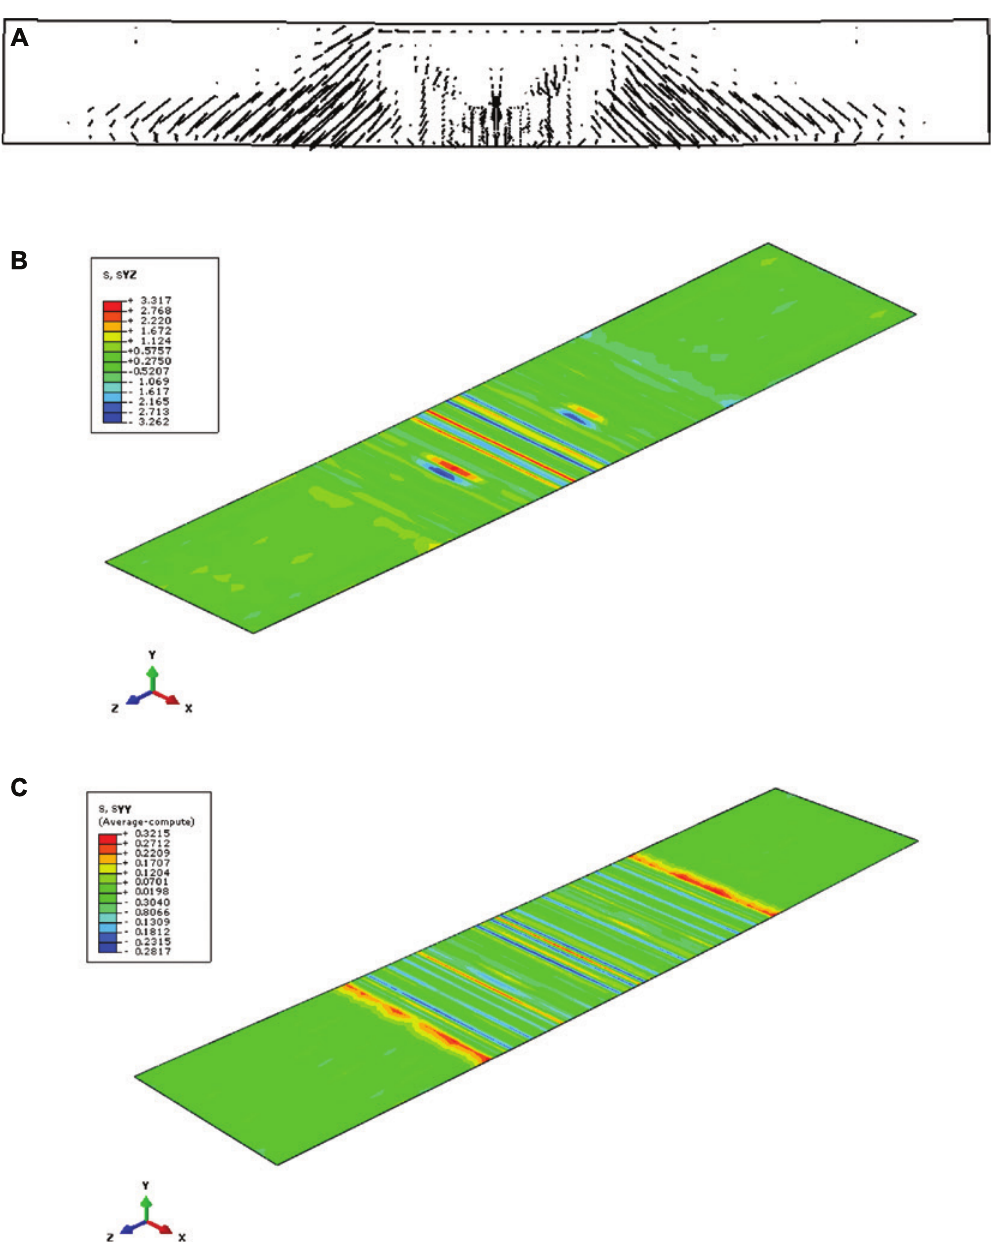
Figure 21: Distribution of (A) concrete cracking, (B) shear stresses in the adhesive layer, and (C) normal stresses in the adhesive layer of a CFRP-retrofitted RC beam after 10,000 cycles. N . Stress contour values are in 2